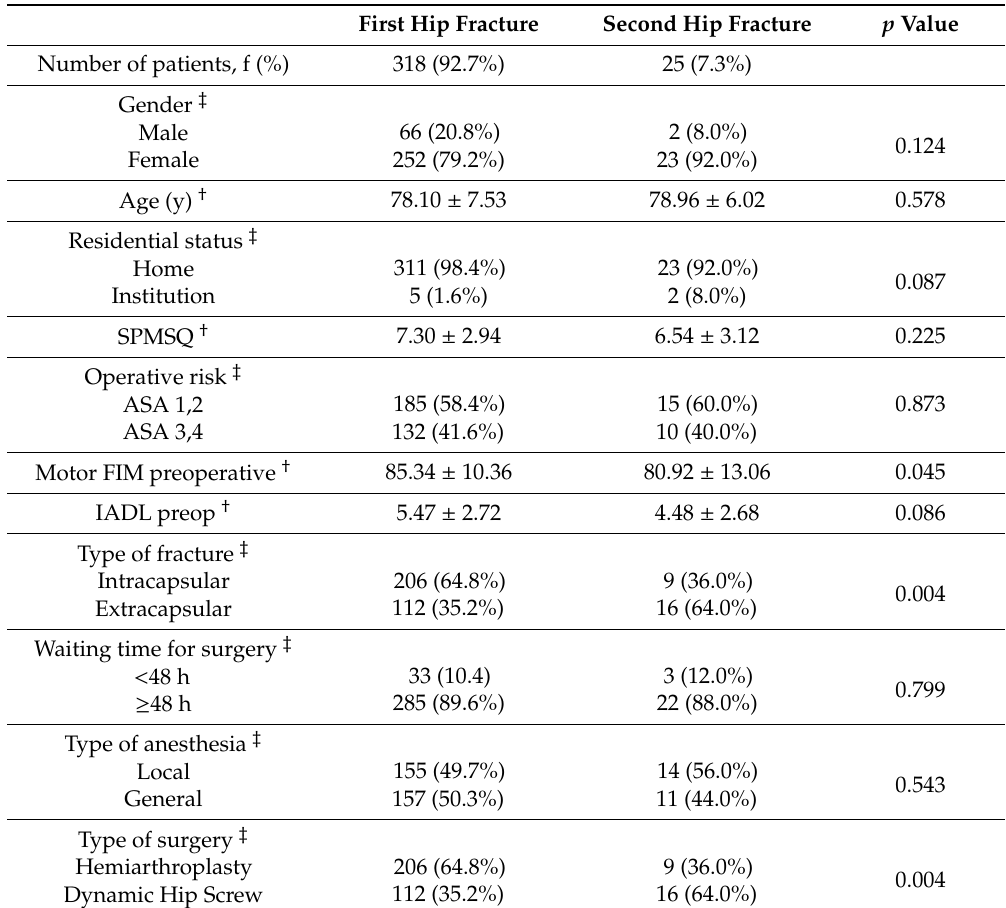
Table 1. Baseline characteristics of study